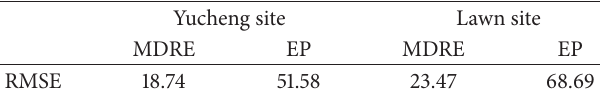
Table 1: The RMSE results of the MDRE and the Noah EP using the two site observations.